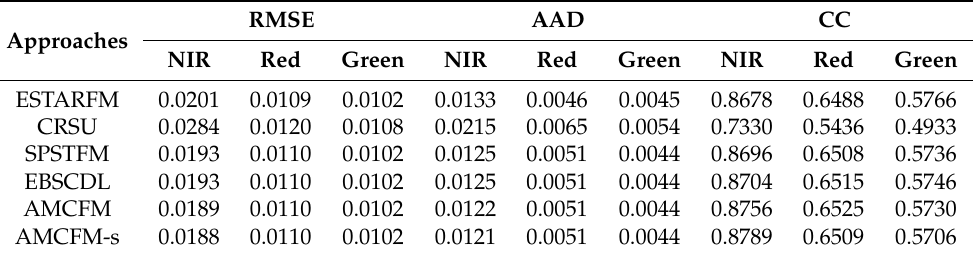
Table 4. Band quality metrics in image 2.